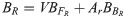
Dynamic simulations.The total number of bacteria, BT, is shown over time for the untreated scenario and for four treatment strategies: regular antibiotic and inhibitor dosing with and without regular debridement, and constant antibiotic concentration with regular inhibitor dosing, with and without regular debridement. Note the log10 scale on the y-axis. Inset graphs show the number of resistant bacteria BR=VBFR+ArBBR. Treatment with constant antibiotics together with regular inhibitor dosing and debridement is most effective, eliminating the bacterial population in all cases (A–D), while regular antibiotic and inhibitor dosing without debridement is least effective, failing to eliminate the bacterial burden in all cases. The remaining two treatment strategies are intermediate in their efficacy, eliminating the bacterial population in some, but not all cases. Eqs 1–11 were solved using ode15s. Parameter values: λ = 0 cm3cell−1hr−1, ρ = 0 hr−1 and ω = 1. Antibiotics doses: 8 μg cm−3, inhibitor doses: 6.12×107 inhib. cm−3, constant antibiotic scenarios: A = 8 μg cm−3. See Tables 2–4 for the remaining parameter values.